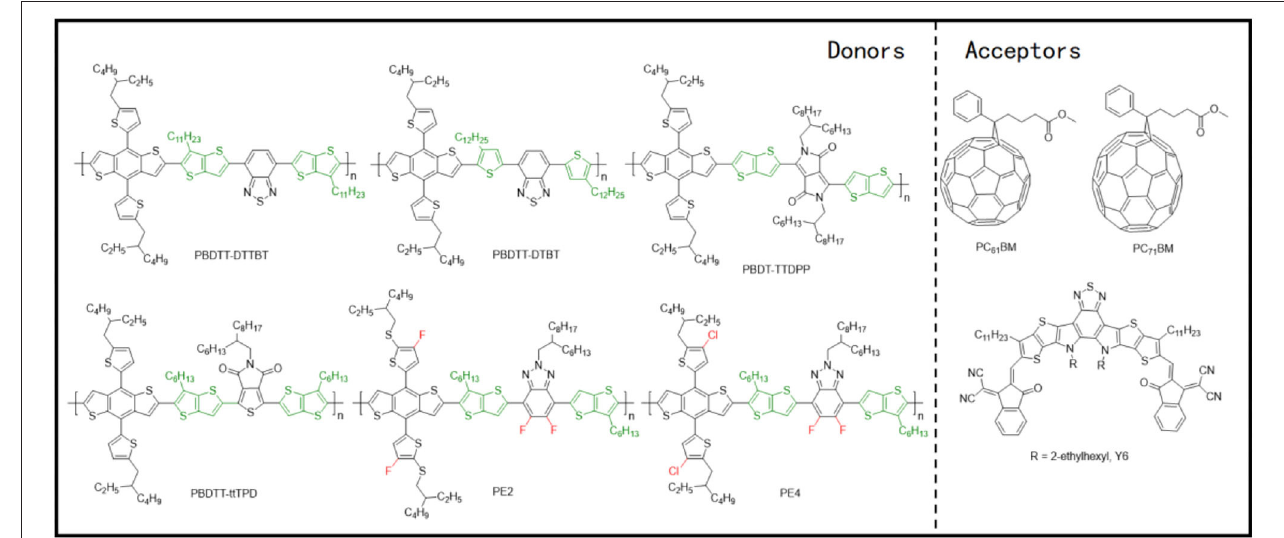
FIGURE 12 | Molecular structures of representative D– π -A copolymers with TT π -bridge and mentioned